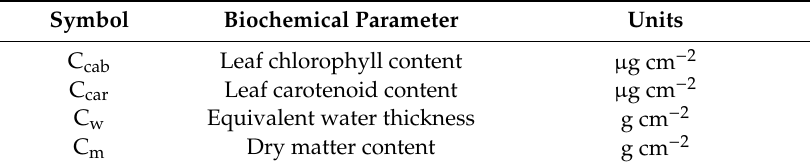
Table 1. Biochemical parameters used by the PROSPECT-5